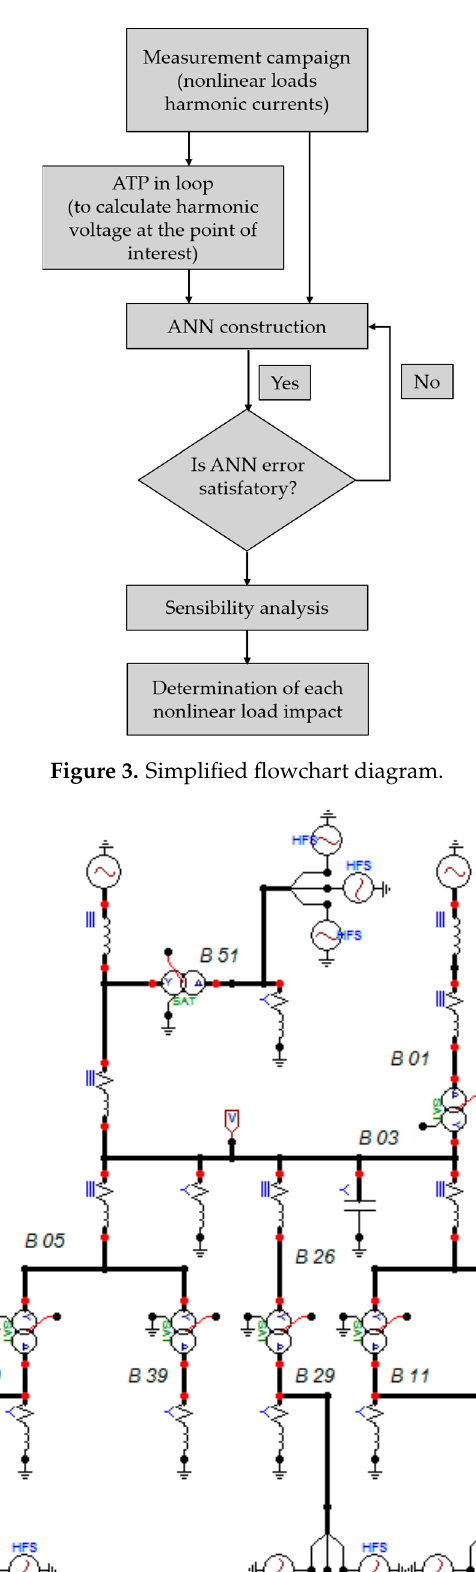
Figure 3. Simplified flowchart diagram.